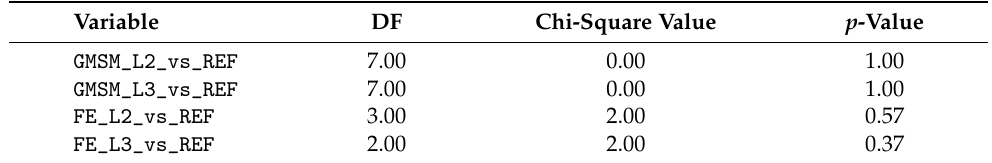
Table 8. Omitted variable test for a random-effects model considering multilevel and endo- geneity: Saving ∼ Score.MCDM_Scores.RoCo + factor.category + factor.organization + ( 1